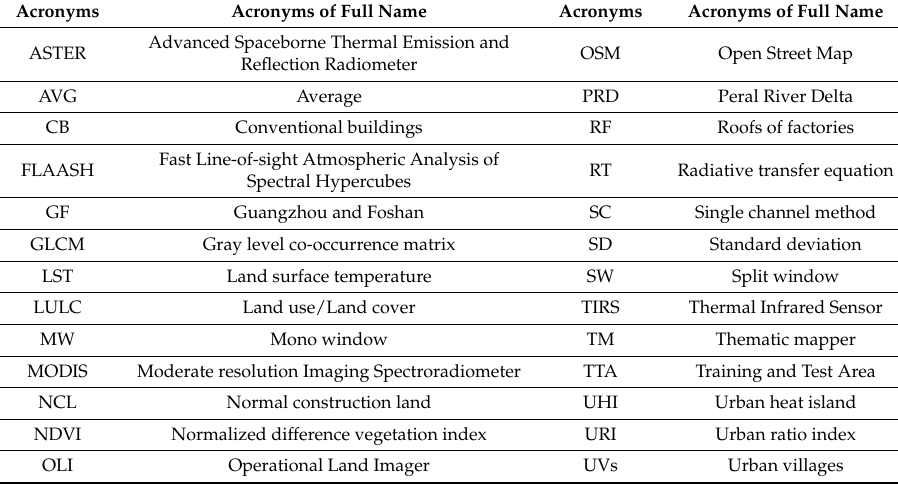
Table A2. List of